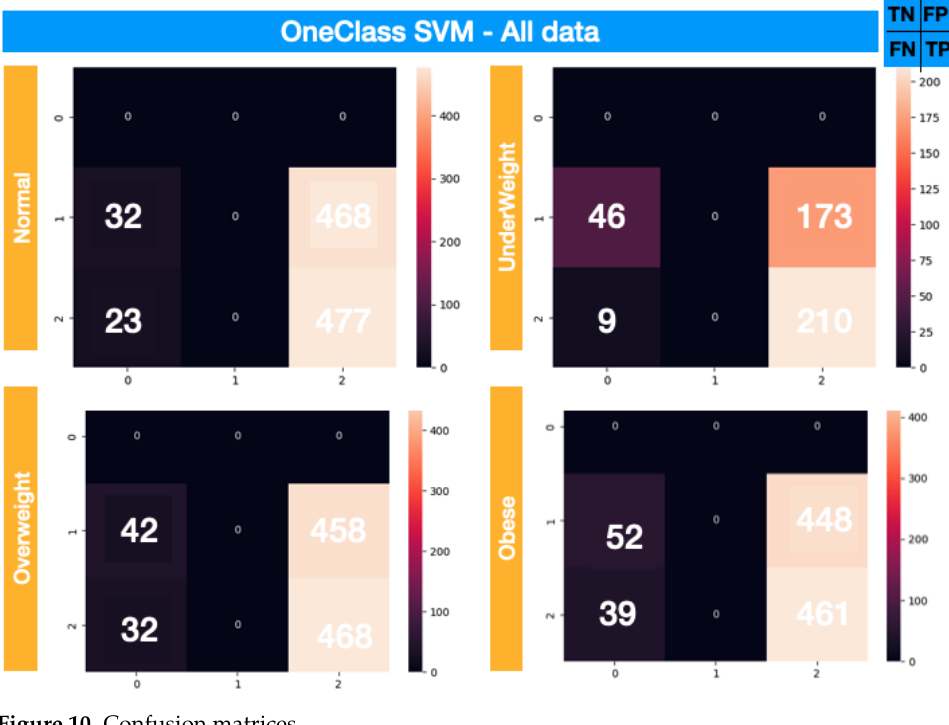
Figure 10. Confusion